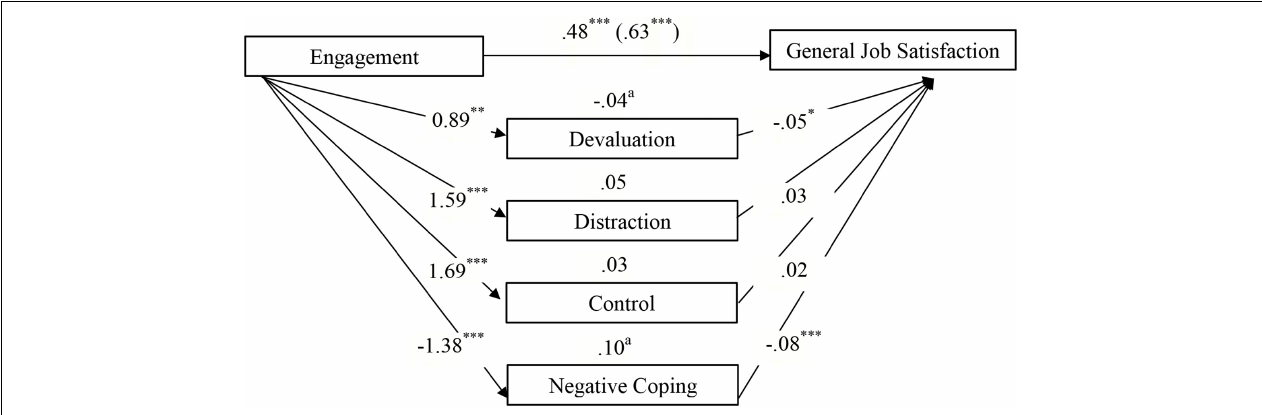
FIGURE 2 | Direct, indirect, and total effects (in brackets) of Engagement on General Job Satisfaction via the mediators Positive (Devaluation, Distraction, Control) and Negative Coping Strategies (Controlled for age and gender). ∗ p < 0.05. ∗∗ p < 0.01. ∗∗∗ p < 0.001. a Significant point estimates ( p < 0.05).